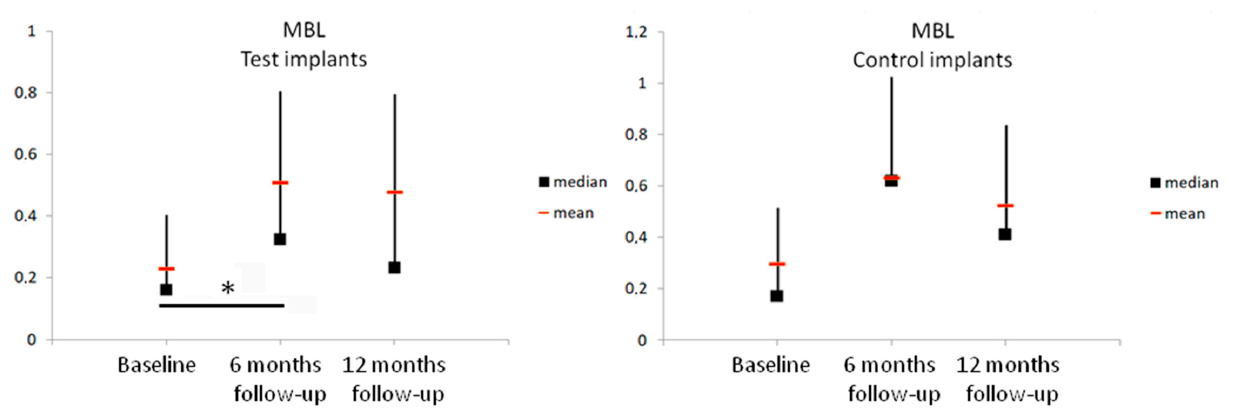
Figure 3. Marginal bone level (MBL) results for test and control implants. Marginal Tissue Height. As for MTB measurements, a first statistical comparison was performed between test and control implants on the difference of MTH values at 12-month follow-ups and baseline (i.e., ∆ MTB 12-month = MTB 12month − MTB baseline ). Mann-Whitney tests showed no difference on ∆ MTH values at 12-month follow-ups between test and control implants ( p = 0.40). In addition, MTH values were not significantly different at baseline and at 12-month follow-up in test ( p = 0.95) and in control ( p = 0.20) implants when test and control implants were analysed separately.